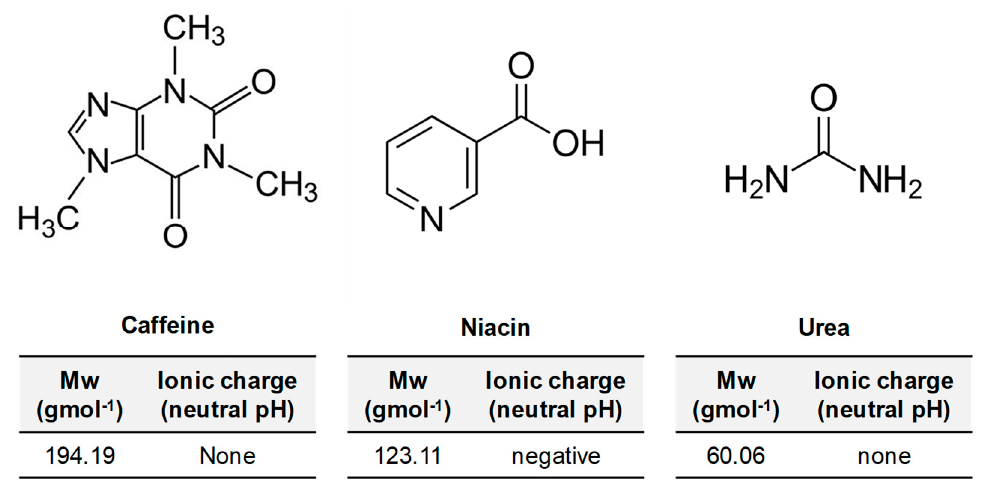
Figure 14. Chemical structures of the model compounds used for the rejection tests. Below the chemical structure, information on the molecular weight (Mw) and molecule charge in a neutral pH solution is described.